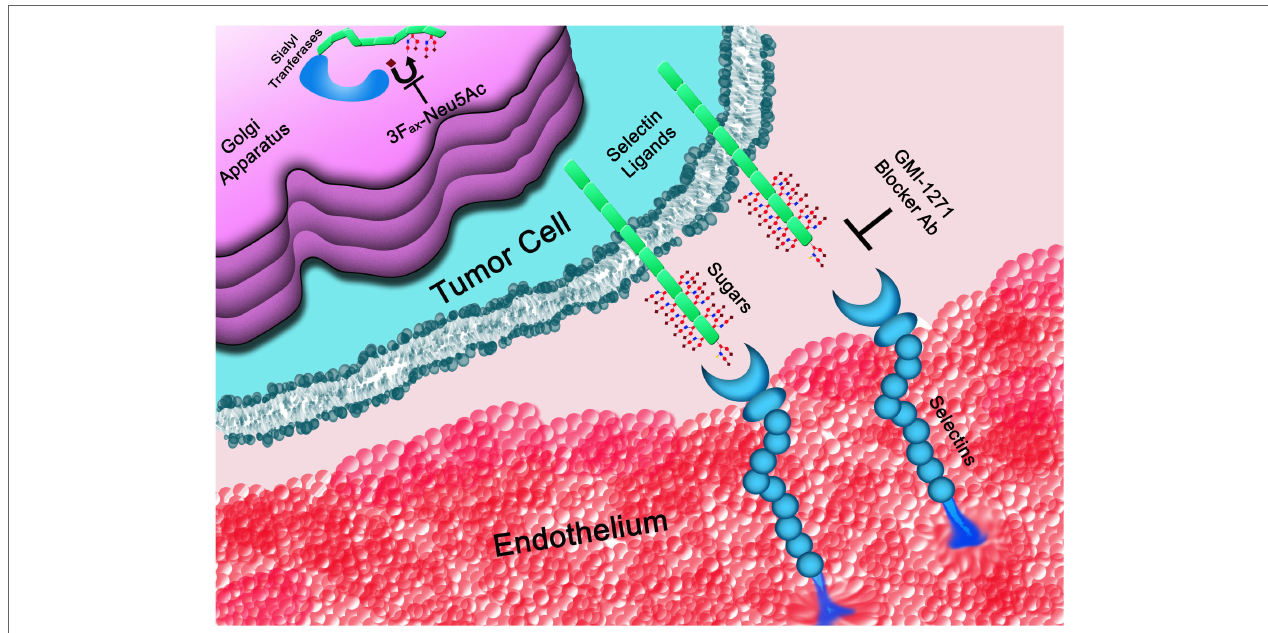
FiGURe 3 | The glycans determinants required for selectins binding are generated within the Golgi apparatus . STs, such as ST3GAL6, are responsible for the covalent linkage of sialic acid ( ⧫ ) to the underline sugar backbone. Once on the cell surface, selectin ligands interact with selectins mediating cell rolling on the vasculature endothelium. Interactions of tumor cells with platelets or the endothelium (represented in the figure) can be blocked at the level of the Golgi apparatus by inhibiting STs or by directly interfering with the binding to selectins using blocker antibodies (Ab) or small molecules, such as GMI-1271, among